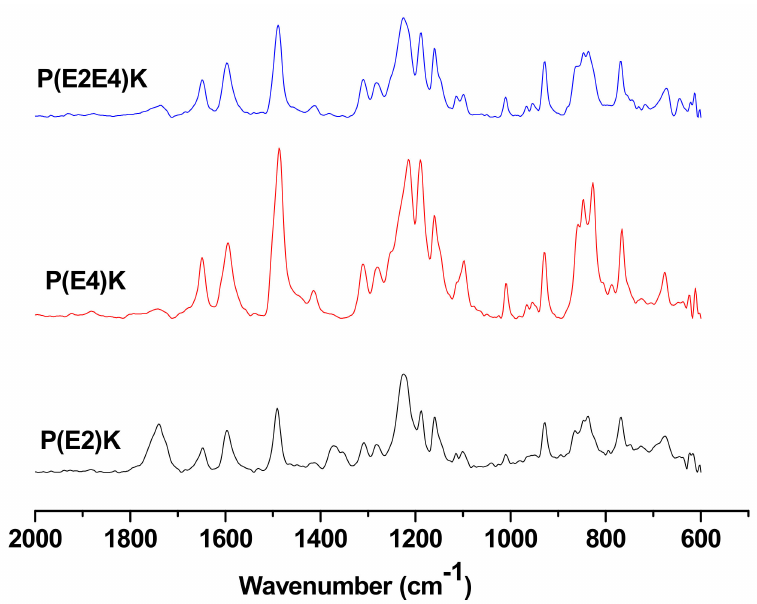
Figure 2. FT-IR spectra of the PEEK homo and copolymers. (Absorbance vs.